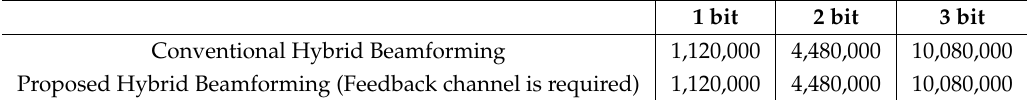
Table 3. The computing complexity according to the number of